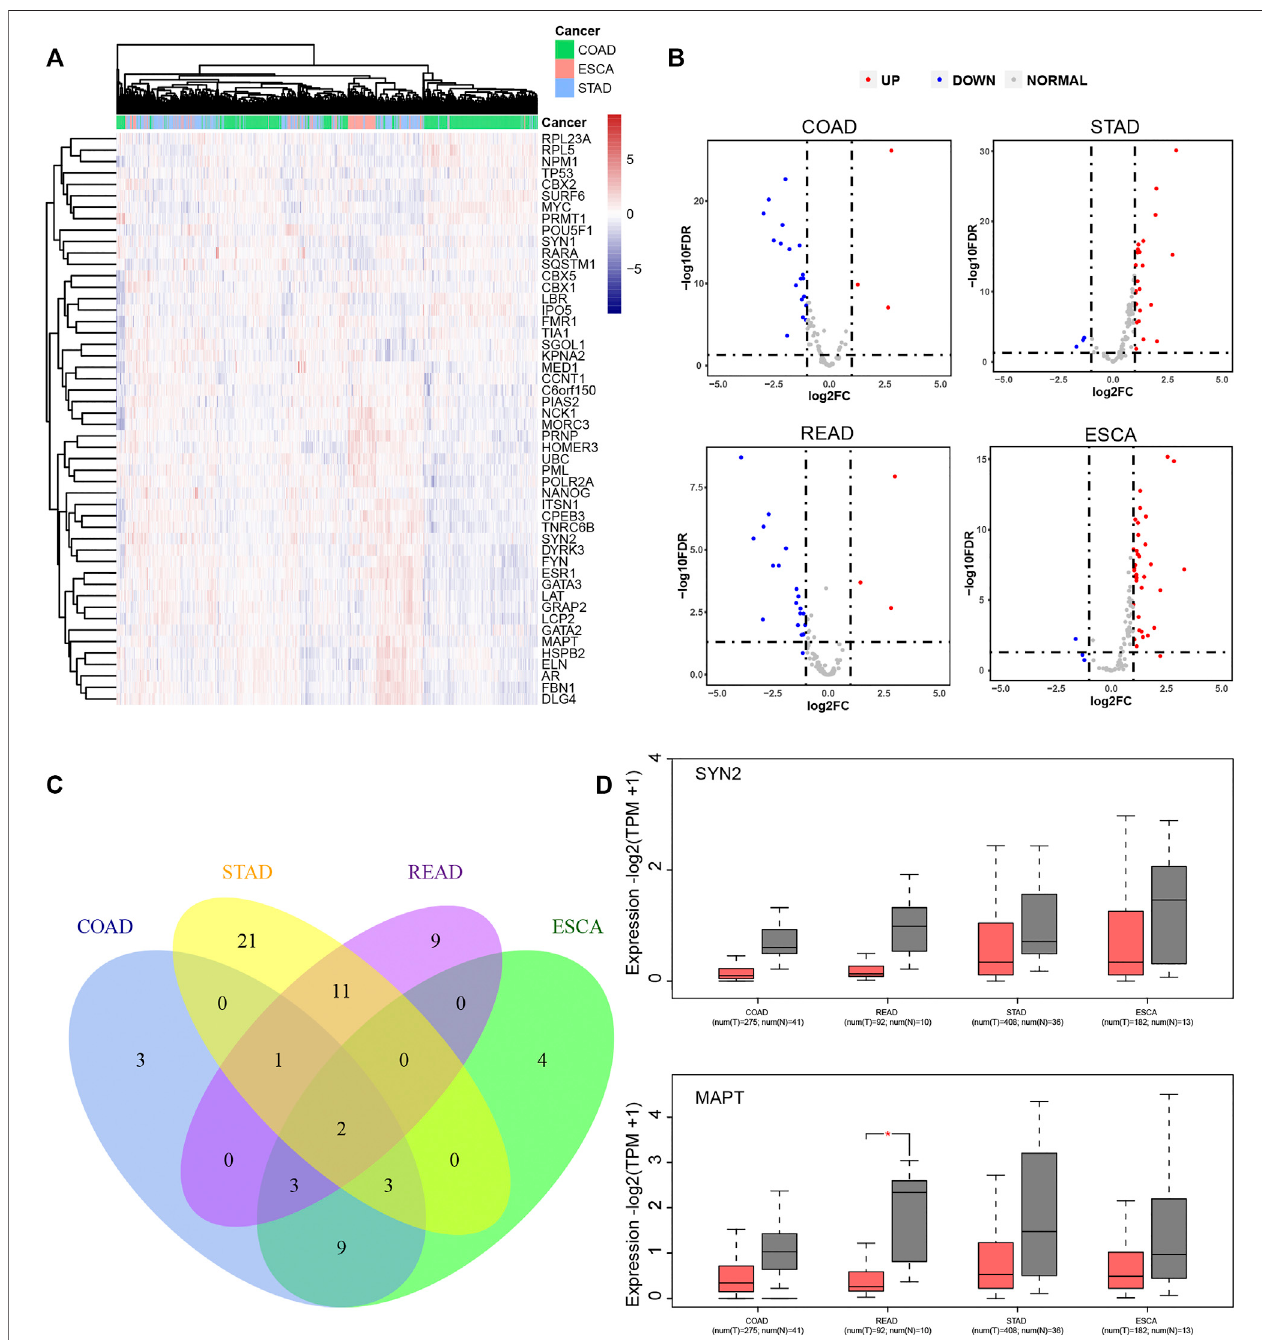
FIGURE 5 | LLPS regulators were signi fi cantly differently expressed in digestive system neoplasms. (A) The heatmap and cluster analysis of the LLPS gene expressioninthedigestivetracttumors. (B) ThevolcanoplotfordifferentialLLPSgeneinthedigestivetracttumors. (C) TheVenndiagramofthedifferentialLLPSamong the digestive tract tumors. (D) The Boxplot of the low expression LLPS gene in all digestive tract tumors.